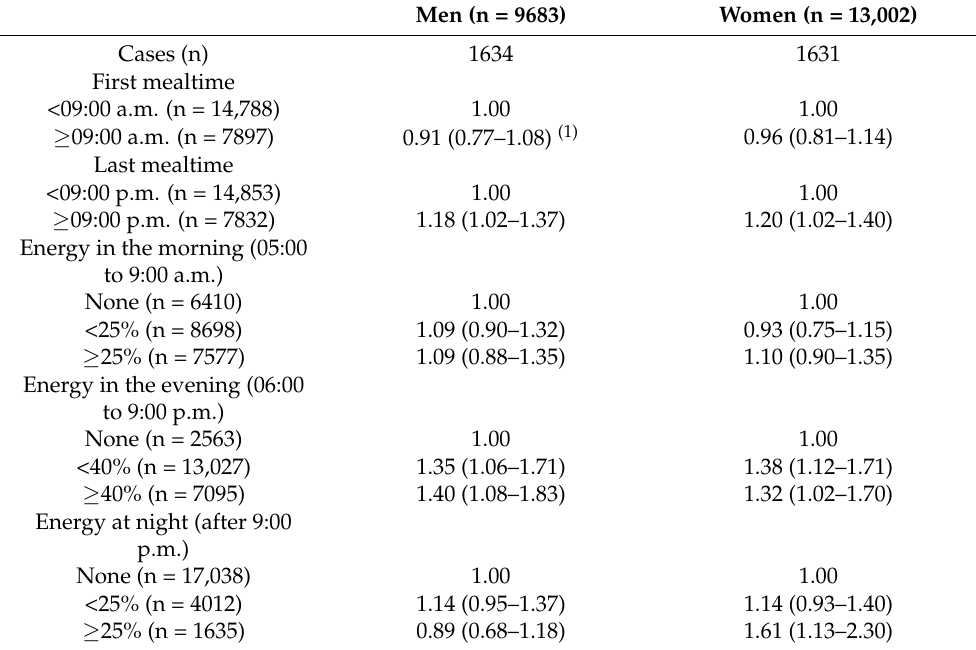
Table 5. Adjusted odds ratios and 95% confidence intervals of type 2 diabetes mellitus based on meal timing in Korean adults. Men (n = 9683) Women (n = 13,002) Cases (n) 1634